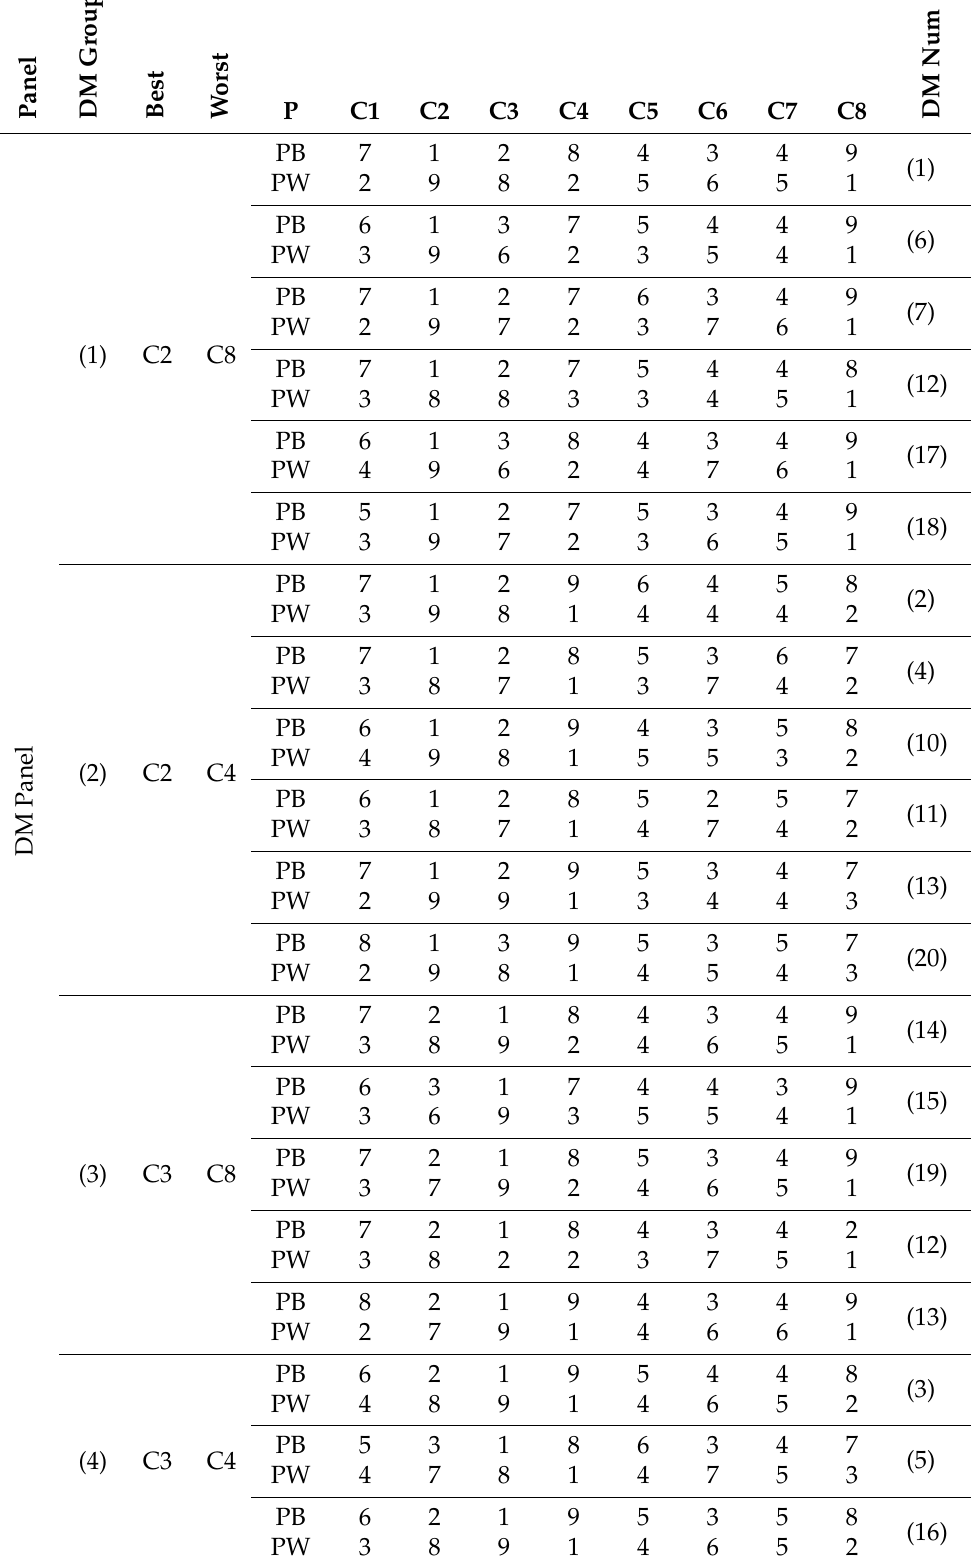
Table 6. Pairwise comparison vector for the best and worst capability